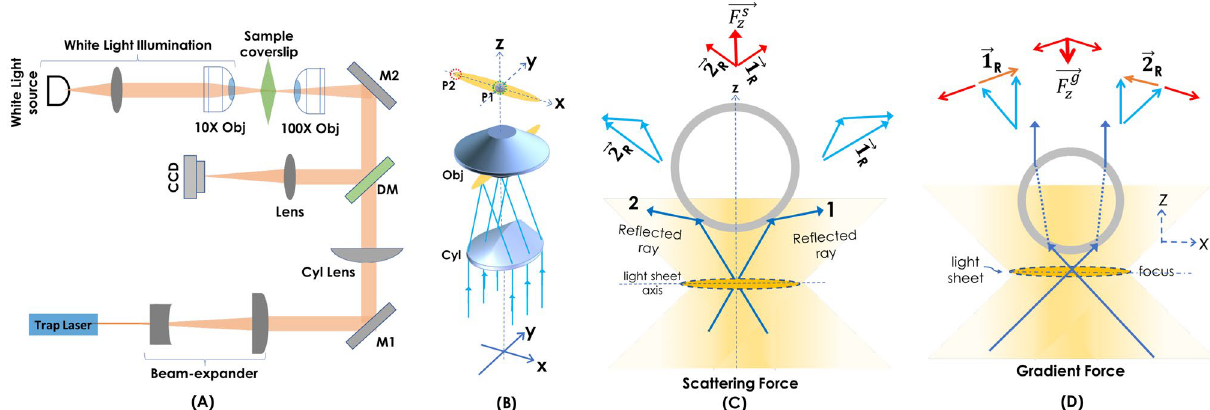
Figure 1. ( A ) Schematic diagram of the developed lightsheet optical tweezer (LOT) system. ( B ) The combination of key optical components (cylindrical lens and high NA objective lens) for generating diffraction- limited light sheet. ( C ) The resultant scattering force (due to the reflection of light) acts on the micro-particle along + z -axis. ( D ) The gradient force (due to refraction) acts inwards (towards the lightsheet axis) on the particle, i.e., along the − z -axis. The force diagrams shown with blue and red arrows indicate elemental